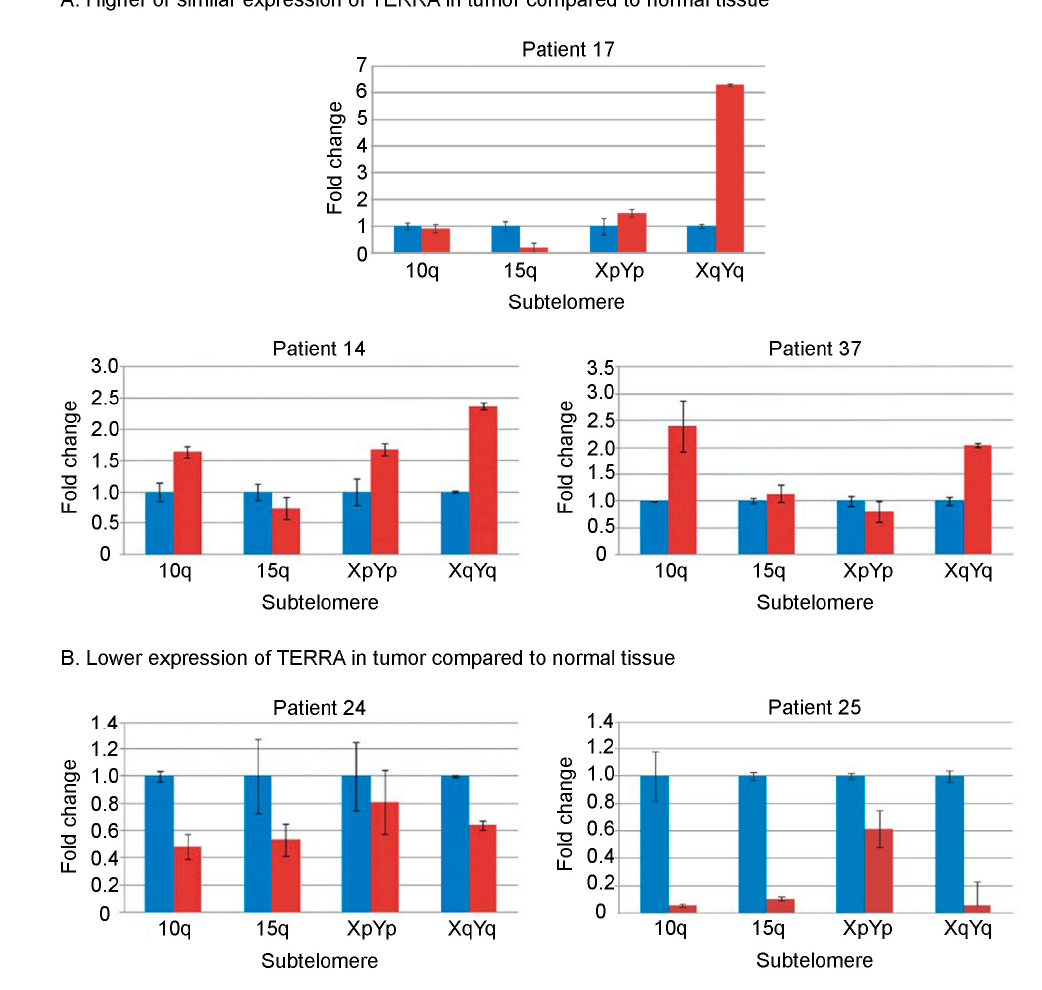
Figure 2. Telomere-specific TERRA levels by qRT-PCR (quantitative Real Time-Polymerase Chain Reaction) in 5 HNSCC patients. Quantitative RT-PCR experiments were carried out to measure of TERRA expression from 10q, 15q, XpYp and XqYq telomeres. Tumor samples (red bars) and samples from adjacent nontumoral tissue (blue bars). For each patient, TERRA expression level in the normal tissue is set to 1 and used as reference. For each sample, three replicates were amplified. ( A ) Patients with higher or similar TERRA levels in tumor compared to normal tissue; ( B ) Patients with lower TERRA levels in tumor compared to normal tissue.